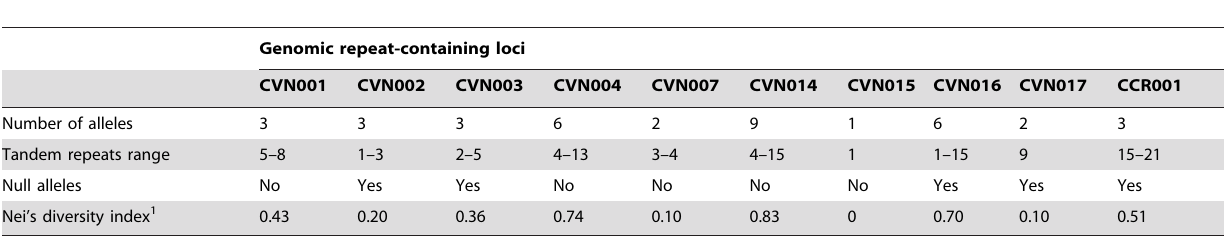
Table 5. Characterization of 10 genomic-repeat containing loci in the non-O157 STEC isolates used in this study.